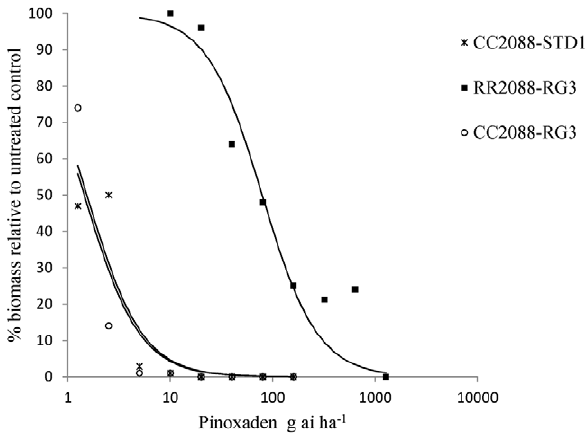
Figure 3. Cycloxydim whole plant dose response assay on wild and mutant 2088 genotypes.